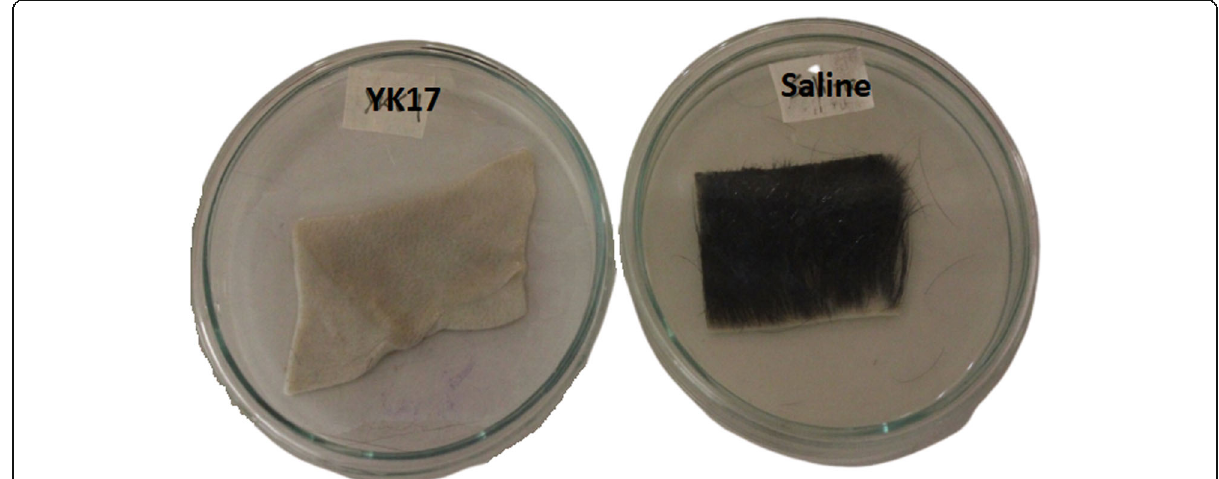
Fig. 5 Dehairing of goat skin by Pseudomonas aeruginosa YK17 after 72